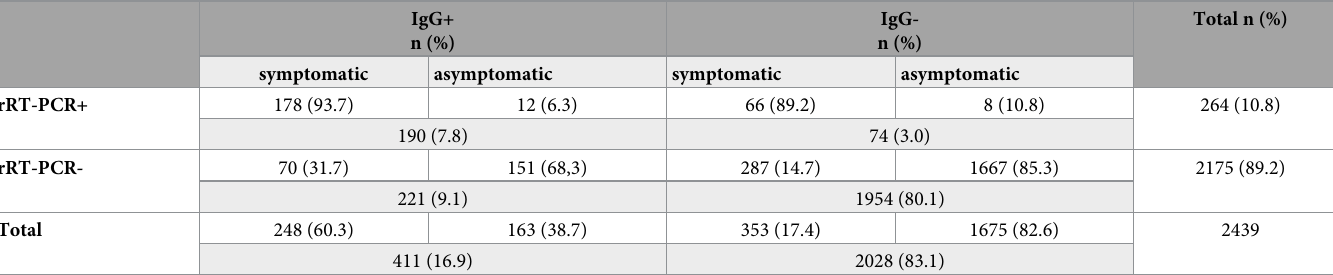
Table 1. Prevalence of symptomatic and asymptomatic cases based on SARS-CoV-2 RT-PCR and IgG